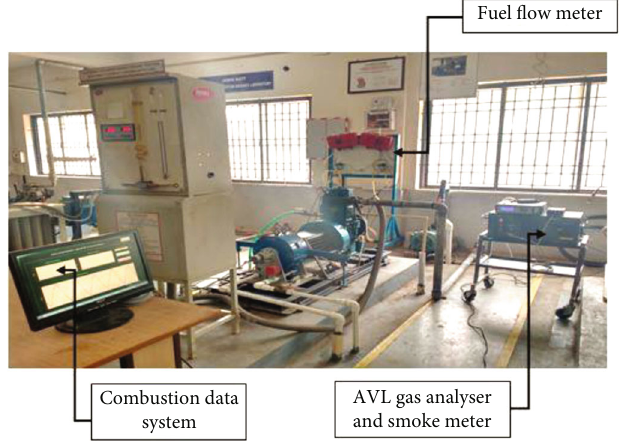
Figure 8: The image of experimental